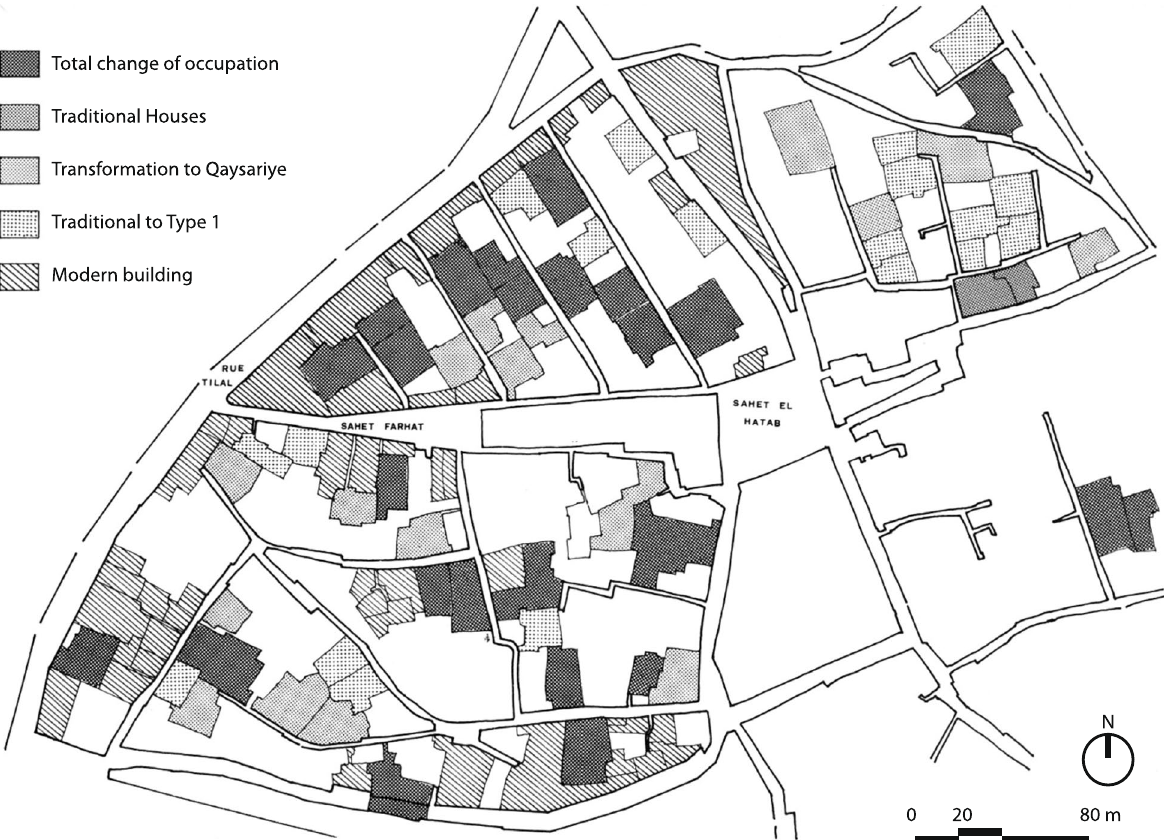
Fig. 7 David’s Survey Showing Changes in the Al-Judayda Area (Source: David 1975,